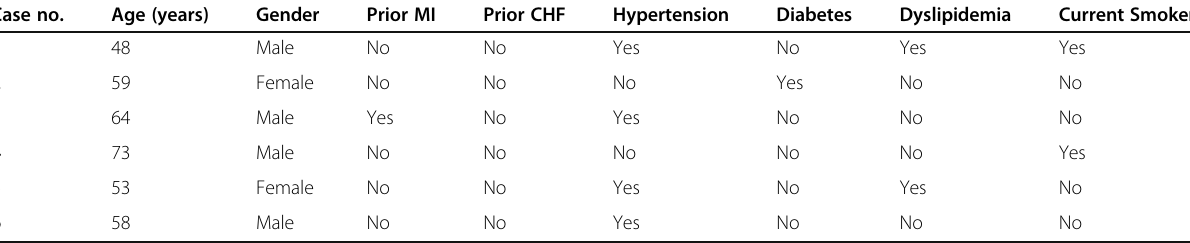
Abbreviations : CHF congestive heart failure, MI myocardial